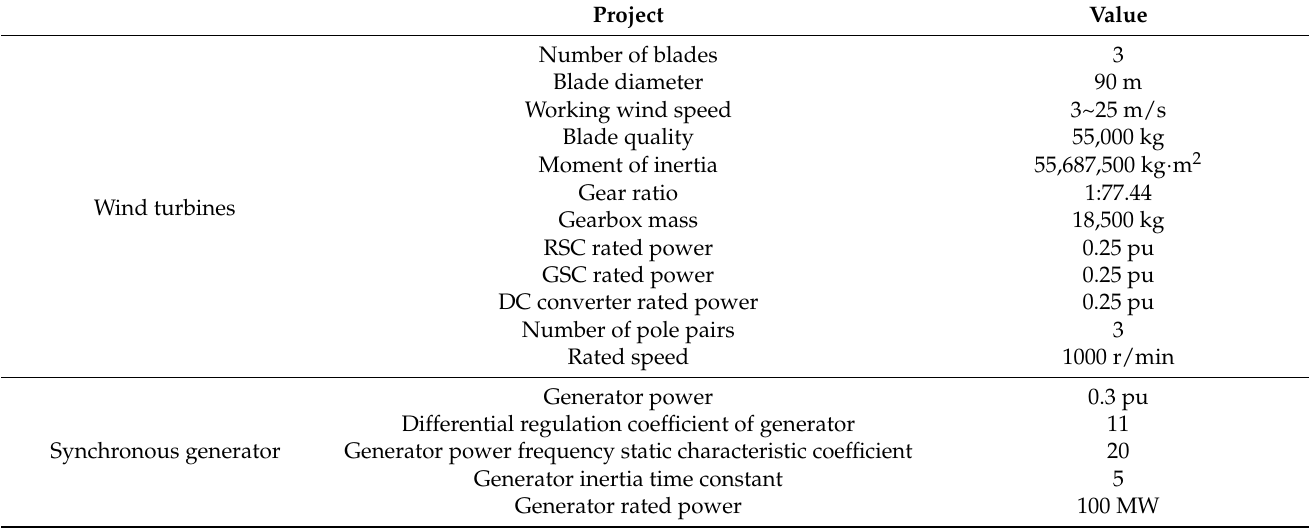
Table A1. Simulation parameters of wind turbines and a synchronous unit. Project